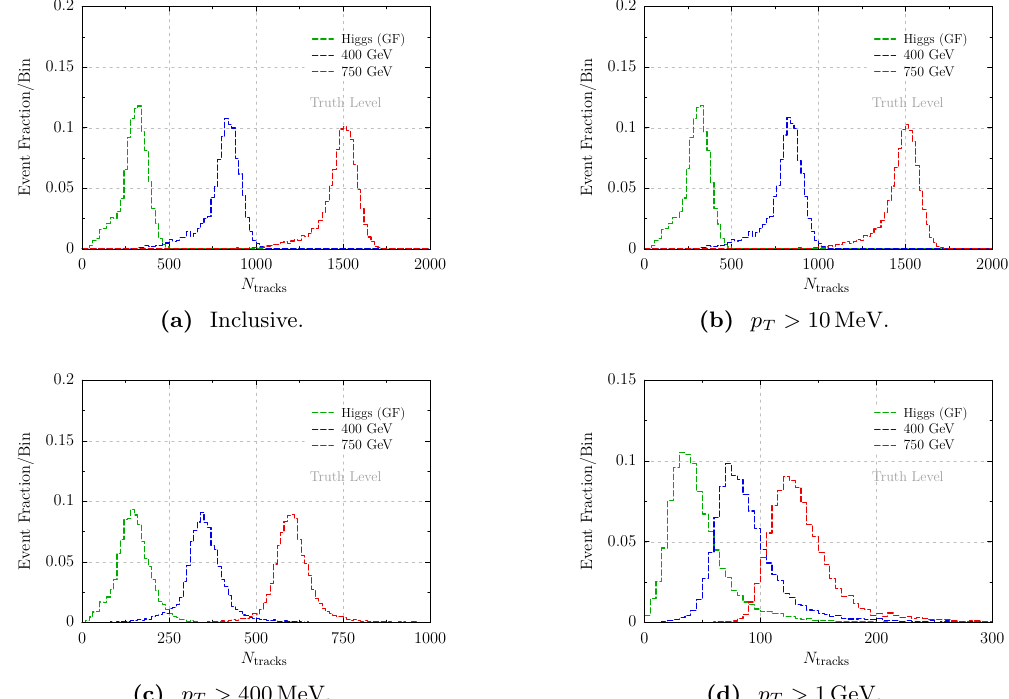
Figure 5. Multiplicity of charged particles with j (cid:17) j < 2 : 4 for the various signal benchmarks, with and without (cid:12)ducial p T